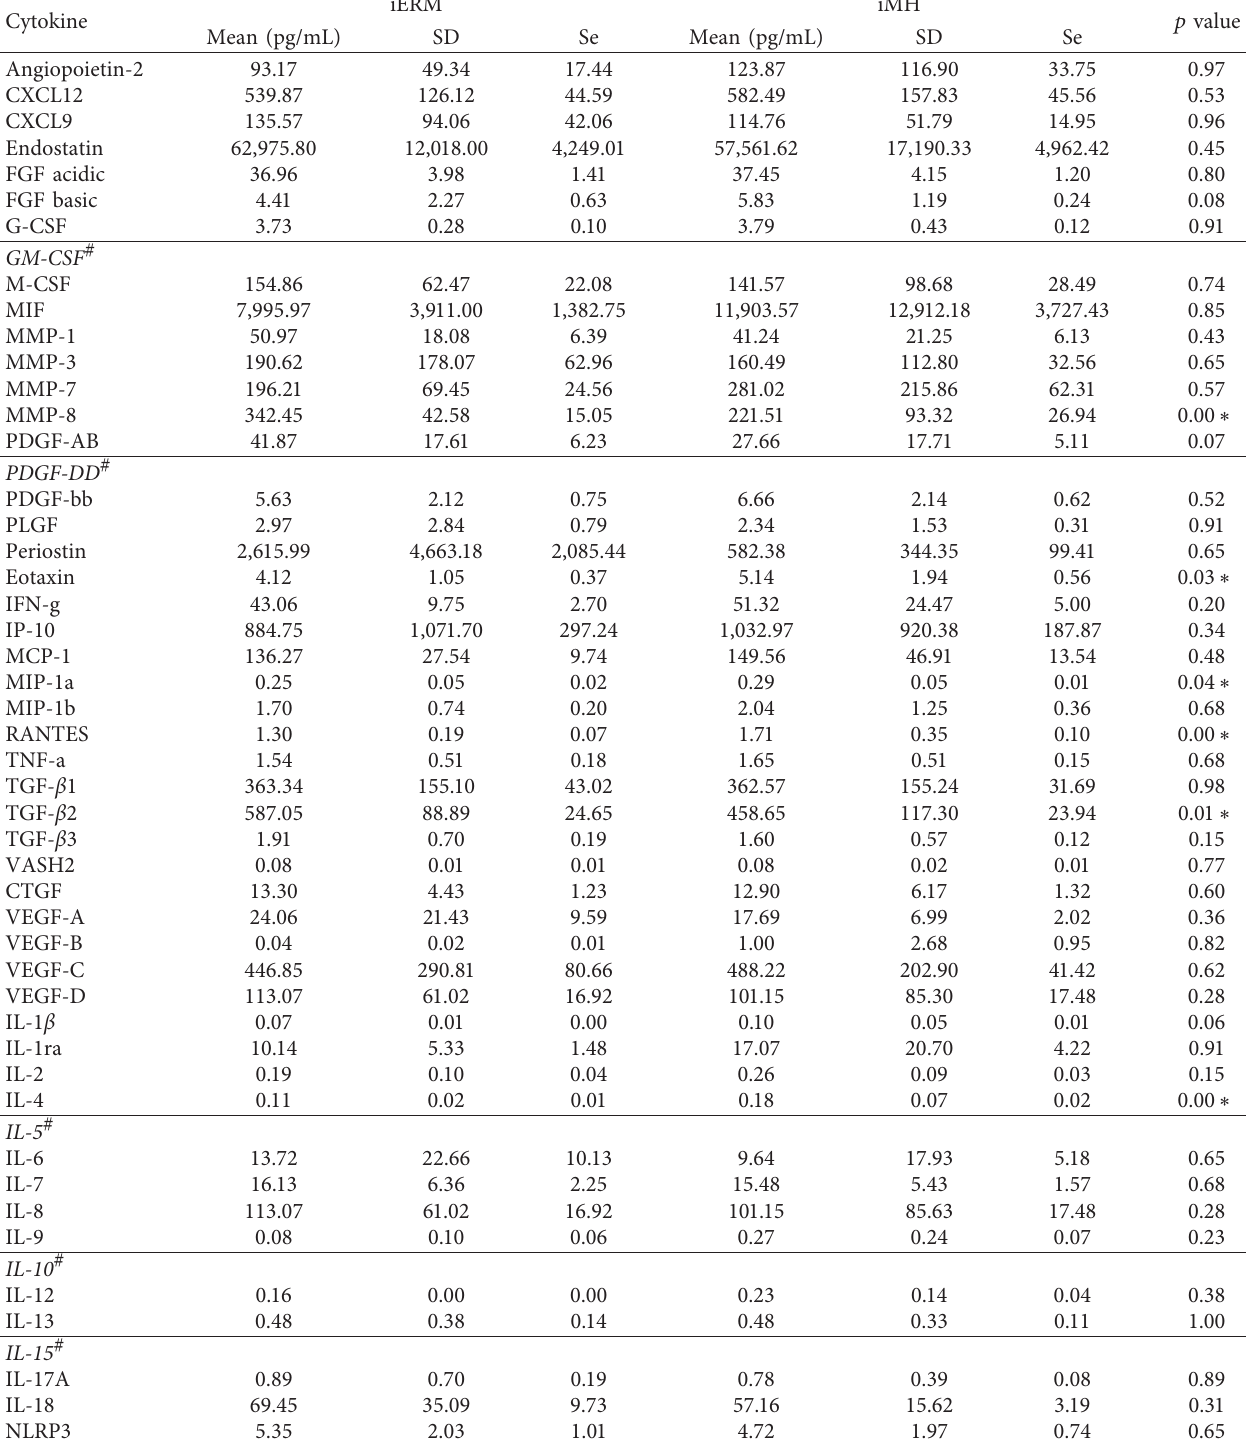
Table 2: Comparisons of 52 vitreal cytokines between iERMs and